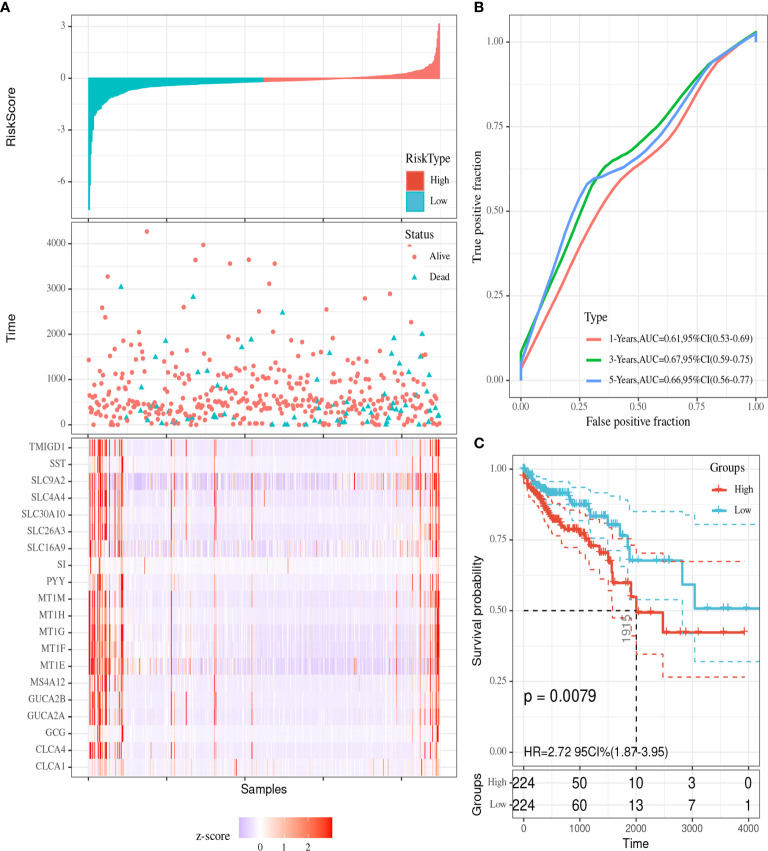
Visualization of the prognostic model. (A) The risk score distribution in colorectal cancer (CRC) patients. (B) ROC curves for the 1-year, 3-year and 5-year survival rates of CRC patients. (C) K-M OS curves for the low-risk and high-risk groups.